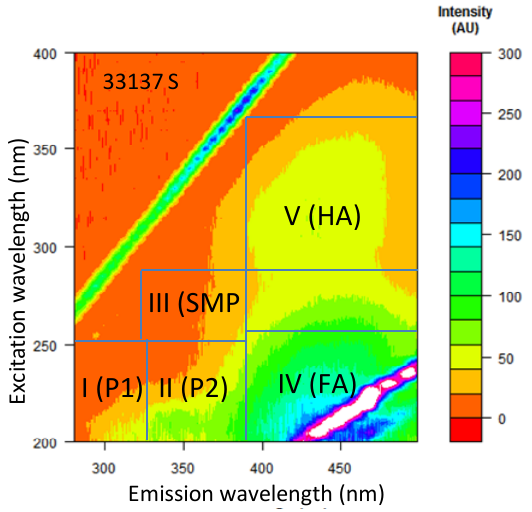
Figure 2. Five EEM regions selected for this study from the surface water of Site 33137 (regions plotted according to Chen et al. , 2003)